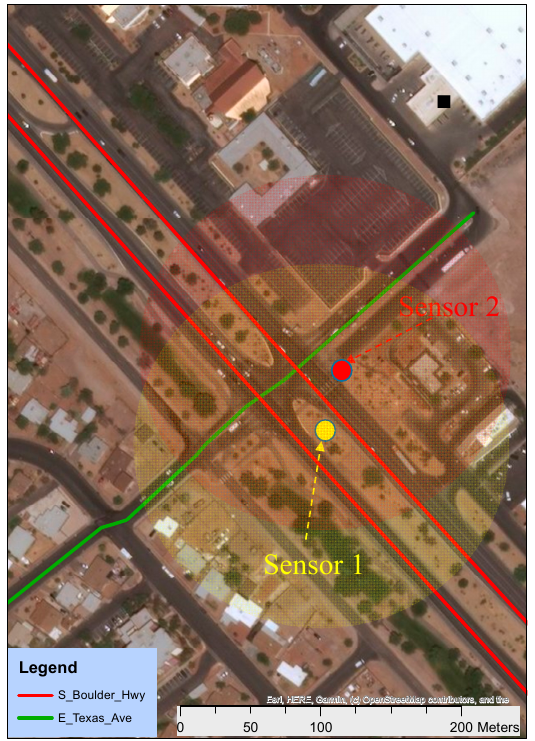
Figure 6. Field site selected for evaluation.